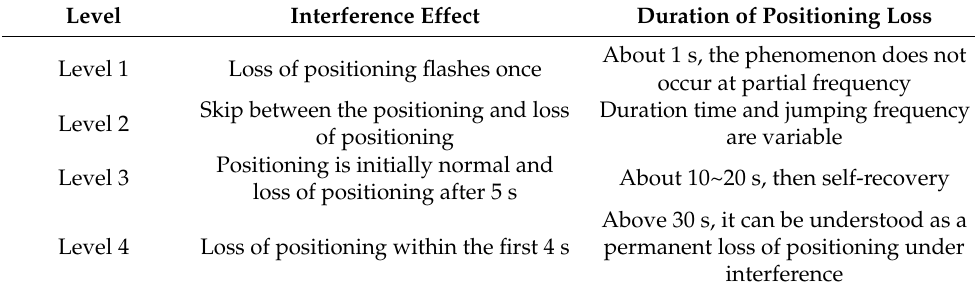
Table 1. Electromagnetic interference sensitive phenomena of the navigation